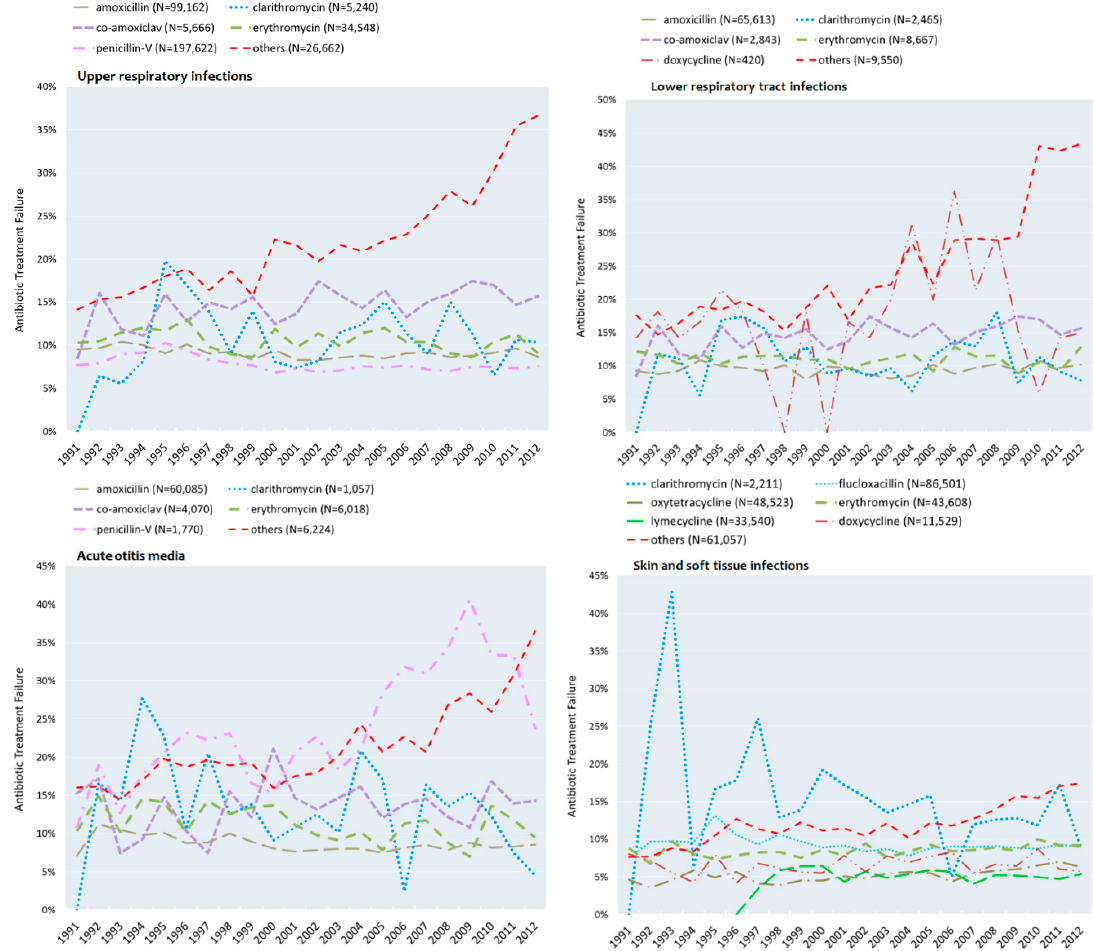
Figure 4. Antibiotic treatment non-response rates observed from 1991 to 2012 for the most commonly prescribed antibiotics in each selected infection class. “Other” antibiotics are defined in Table 2.